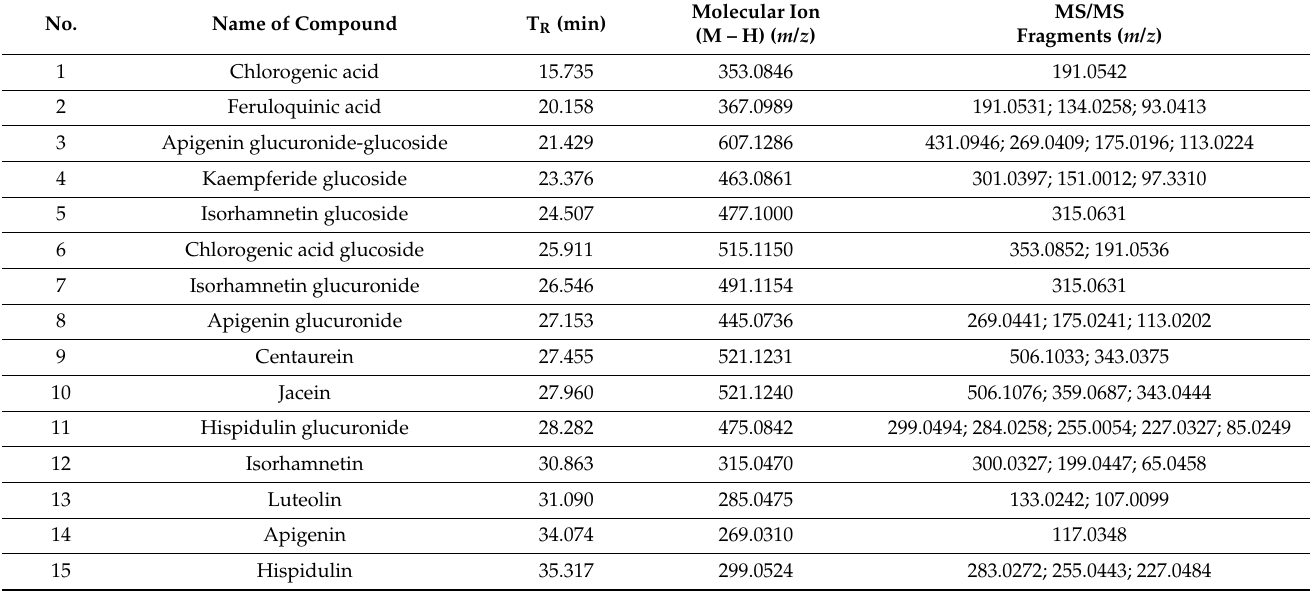
Table 2. CAS MeOH extract. Fragmentation analysis of identified compounds by LC/(-)ESI–QTOF–